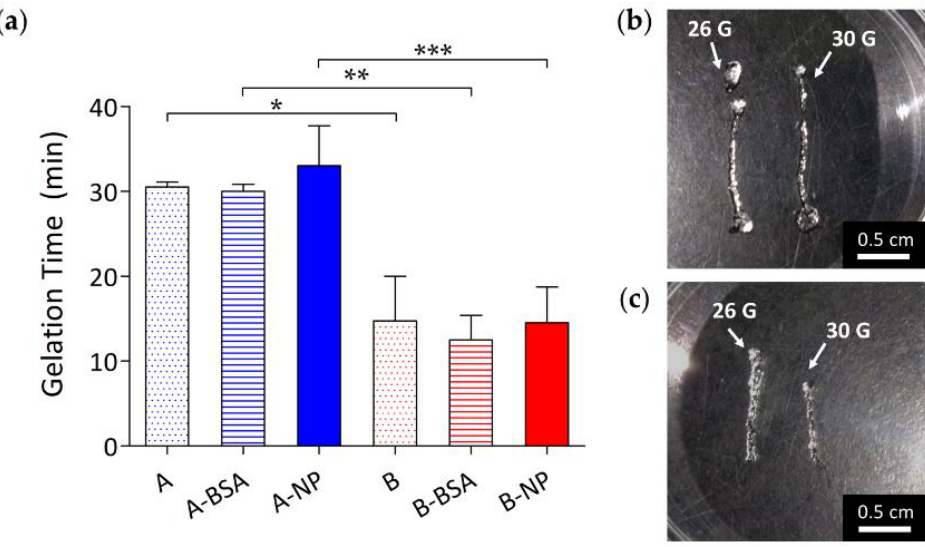
Figure 3. ( a ) Gelation time of hydrogels with polymer concentrations of 1.5% (A groups) and 3% (B groups) loaded with nothing (A and B), BSA (A-BSA and B-BSA), and BSA-laden PLGA NPs (A-NP and B-NP). Gelation times of the A groups were significantly longer than the B groups due to the higher initial polymer concentration of the B groups. Injection feasibility of group A and group B hydrogels are shown as ( b ) and ( c ), respectively. These hydrogels can be easily injected through 26 G and 30 G needle. (*: p ≤ 0.05; **: p ≤ 0.01; ***: p ≤ 0.001).